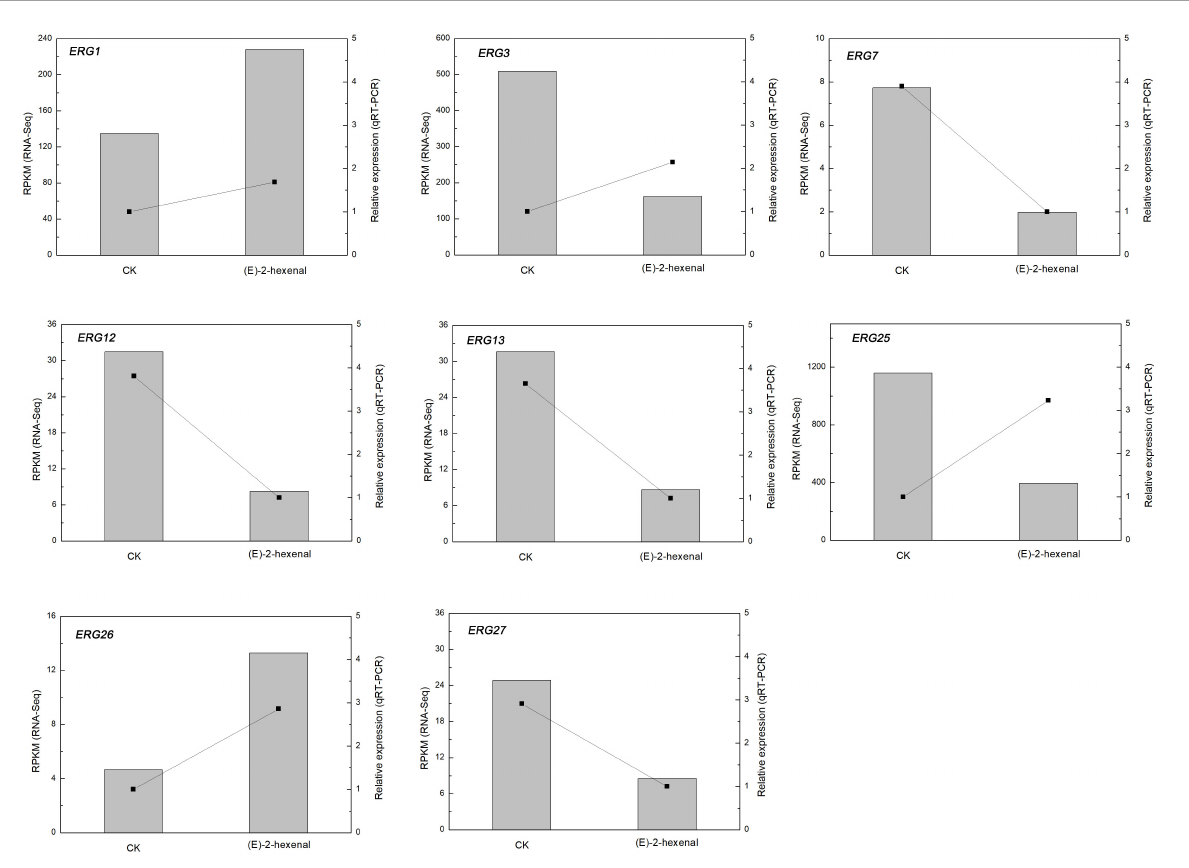
FIGURE7 Changes in the expression of ergosterol biosynthesis genes of B. cinerea mycelia treated by CK and 1 × MFC ( E )-2-hexenal for 2 h. Data from qRT-PCR were normalized relative to the geometric average of BcRPL5 . The relative expression level of each gene in CK was set at 1, and the values are the mean + SD of three replications. The normalized expression level (RPKM) of RNA-Seq is indicated on the y